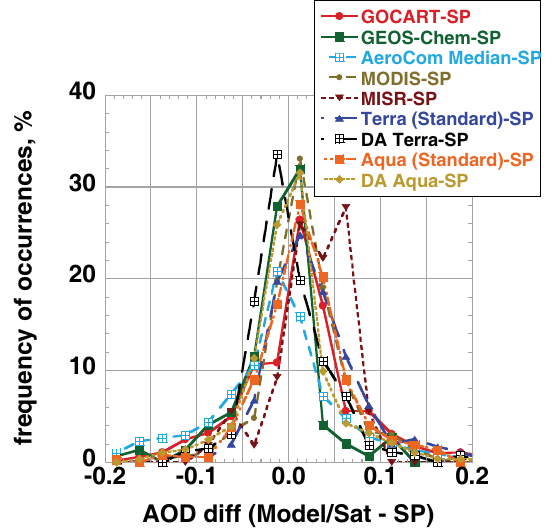
Fig. 10. Frequency of occurrences of aerosol optical depth differ- ences between various models/sensors and